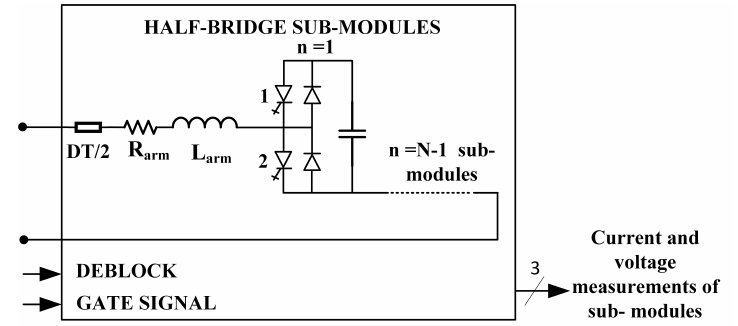
Figure 2. An arm representation of MMC in the RSCAD [26].